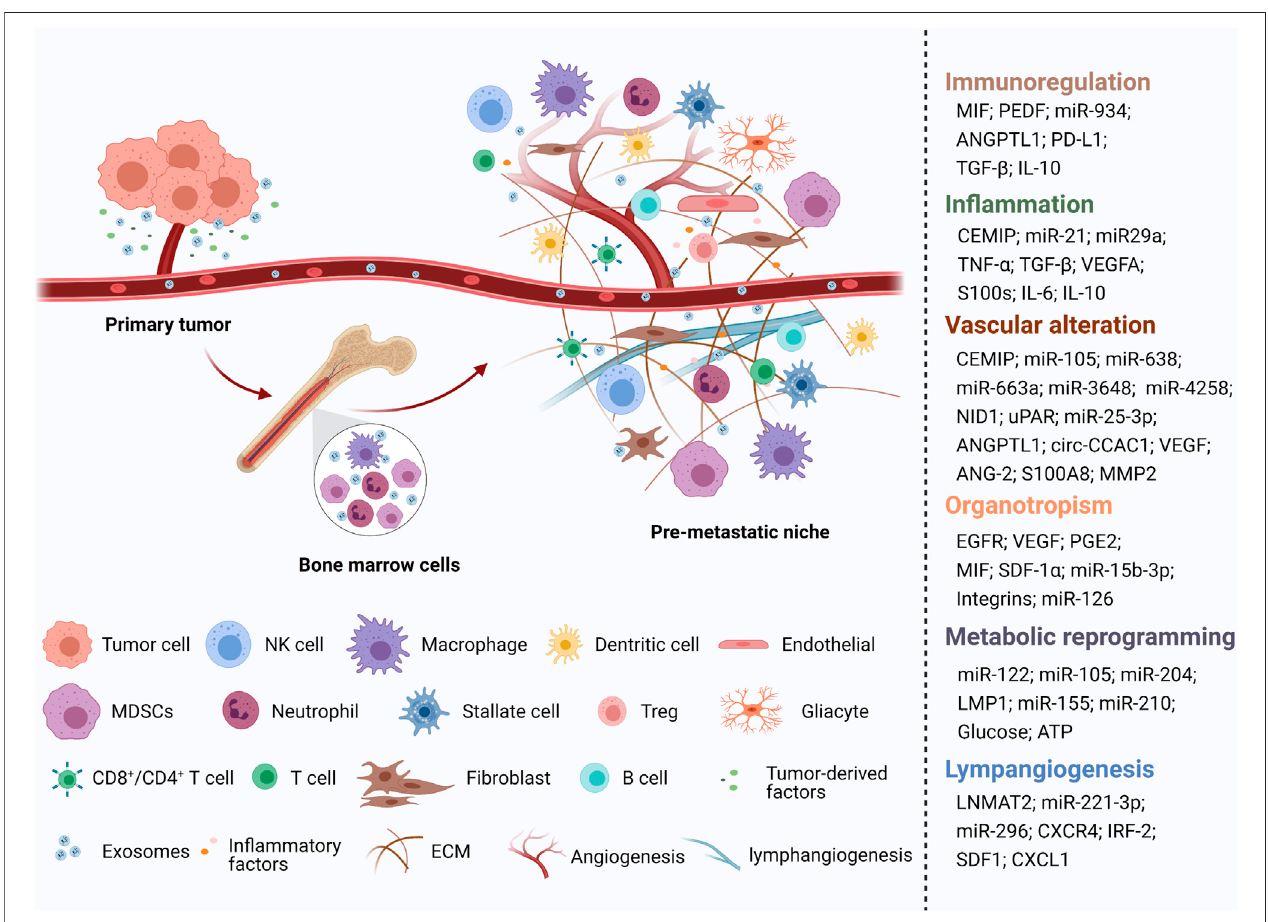
FIGURE 2 | An illustration showed the role of tumor-derived exosomes in PMN formation [created with BioRender.com (https://biorender.com/)].